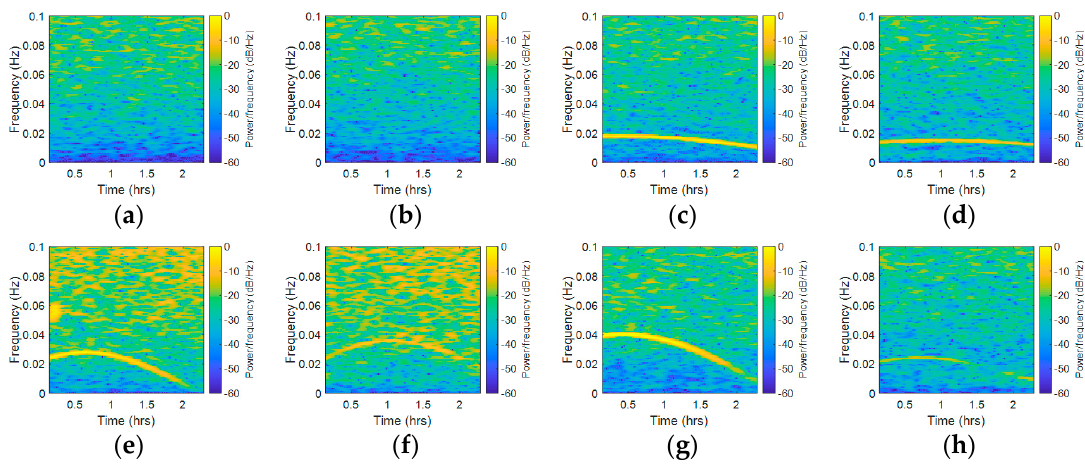
Figure 11. STFT results of Site A and Site B (baseline 29.08 m), ( a ) Site A, C01, ( b ) Site B, C01, ( c ) Site A, C06, ( d ) Site B, C06, ( e ) Site A, R05, ( f ) Site B, R05, ( g ) Site A, G02, ( h ) Site B, G02 .